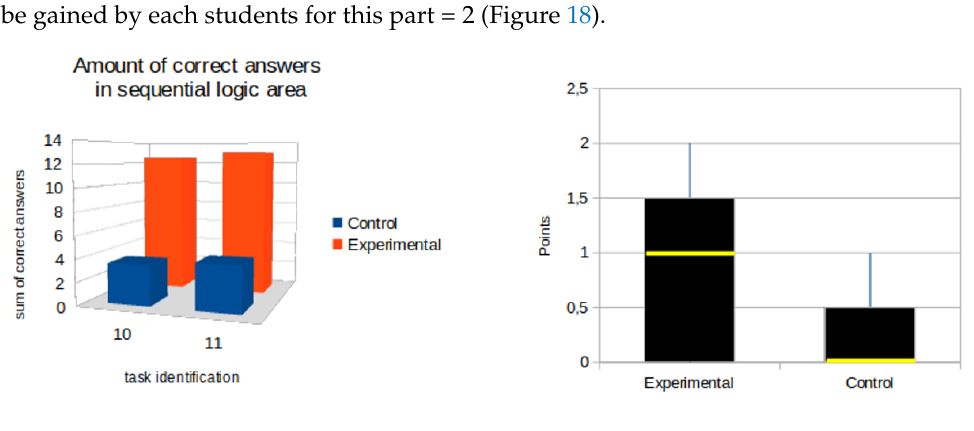
Figure 18. Correct answers in total per task (l) and quartile graphs for points gained